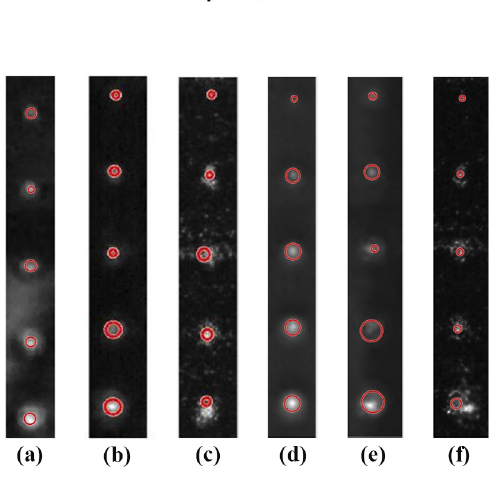
Figure 7. Defects detected at measured surface roughness at 5MHz